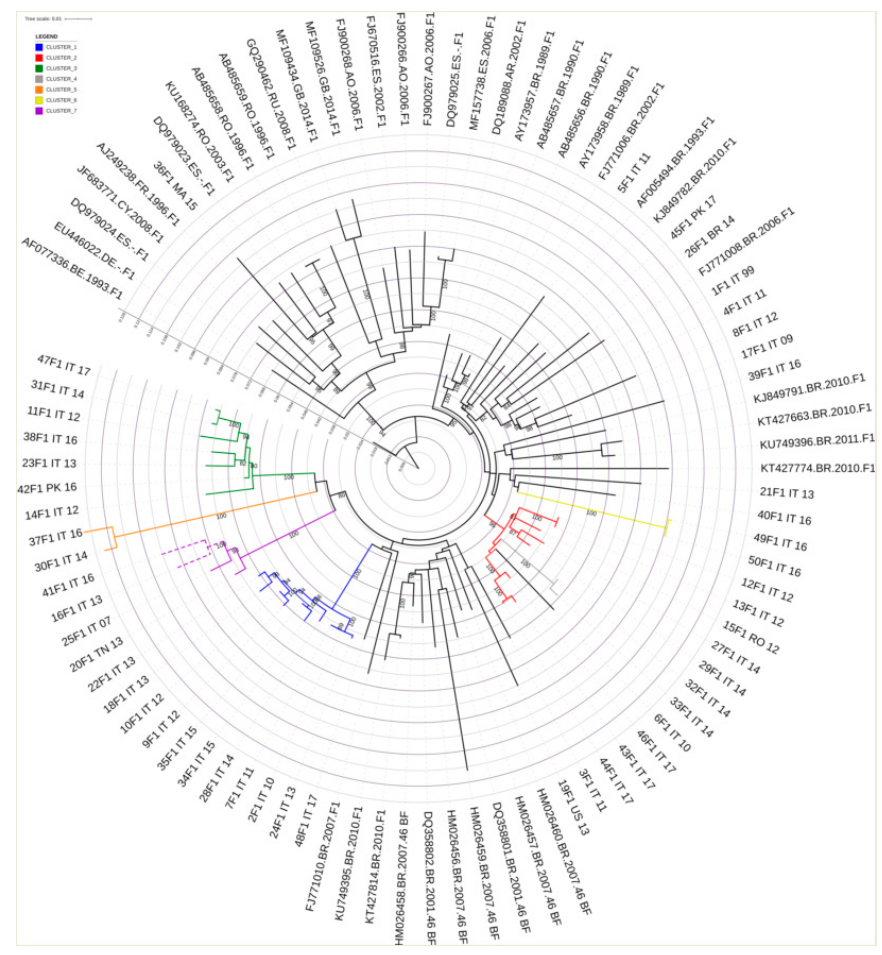
Figure 5. Phylogenetic inference derived from sequence analysis of the subtype F1. Maximum likelihood phylogenetic tree was built by using the iq-tree software and displayed via i-Tol. The substitution model used was GTR + G + I, with 1000 replicates in bootstrap analysis. Branch support values are shown for each tree, consisting of related bootstrap proportions. Compressed clades represent the control group for correct phylogeny inference. Colored branches indicate Italian transmission clusters.